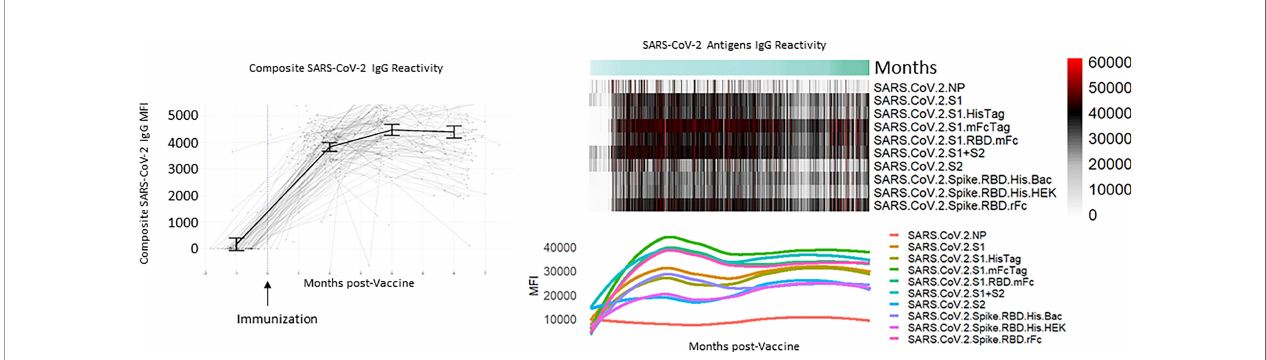
FIGURE 1 | Composite and individual SARS-CoV-2 IgG levels over time for the longitudinal cohort. Background lines (left) representing individual study participants and thick solid line representing mean antibody level at baseline, 2 months, 4 months, and 6 months with error bars representing 95% con fi dence intervals with heatmap and individual antibody